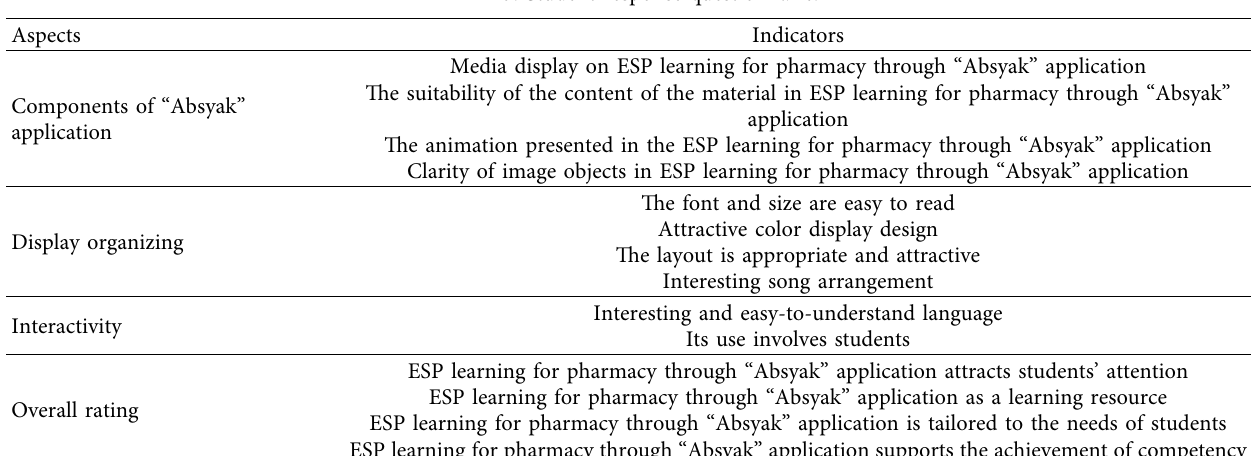
Table 5: Student response questionnaire.